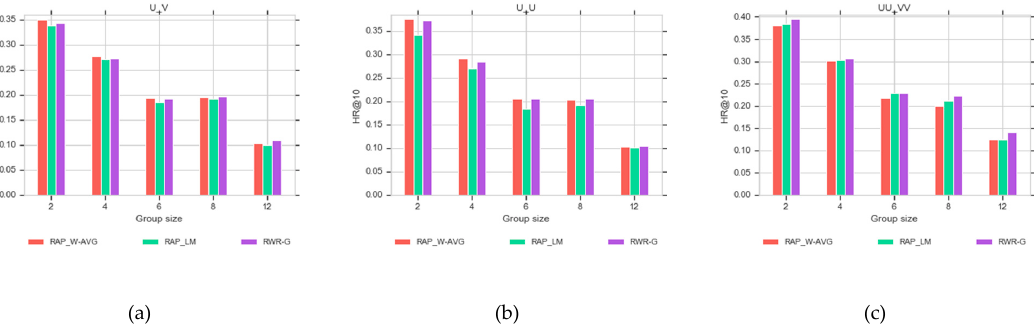
Figure 8. HR values of the RWR algorithm at top-10 recommendations (vertical axis) in different recommendation strategies, including RAP_LM, RAP_W-AVG, and RWR-G at di ff erent group sizes (horizontal axis) and three graph models: ( a ) U-V graph; ( b ) U-U graph, and ( c ) UU-VV graph.